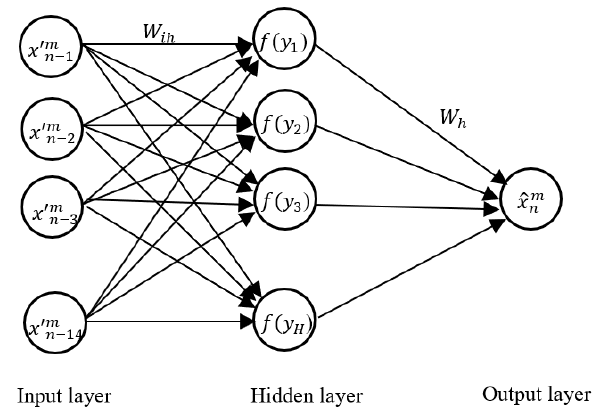
Figure 3. MLP structure.